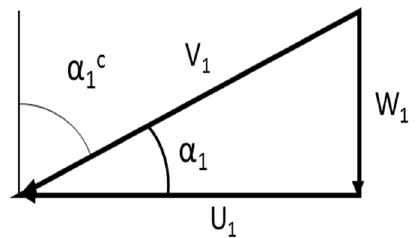
Figure 10. General inlet velocity triangle.